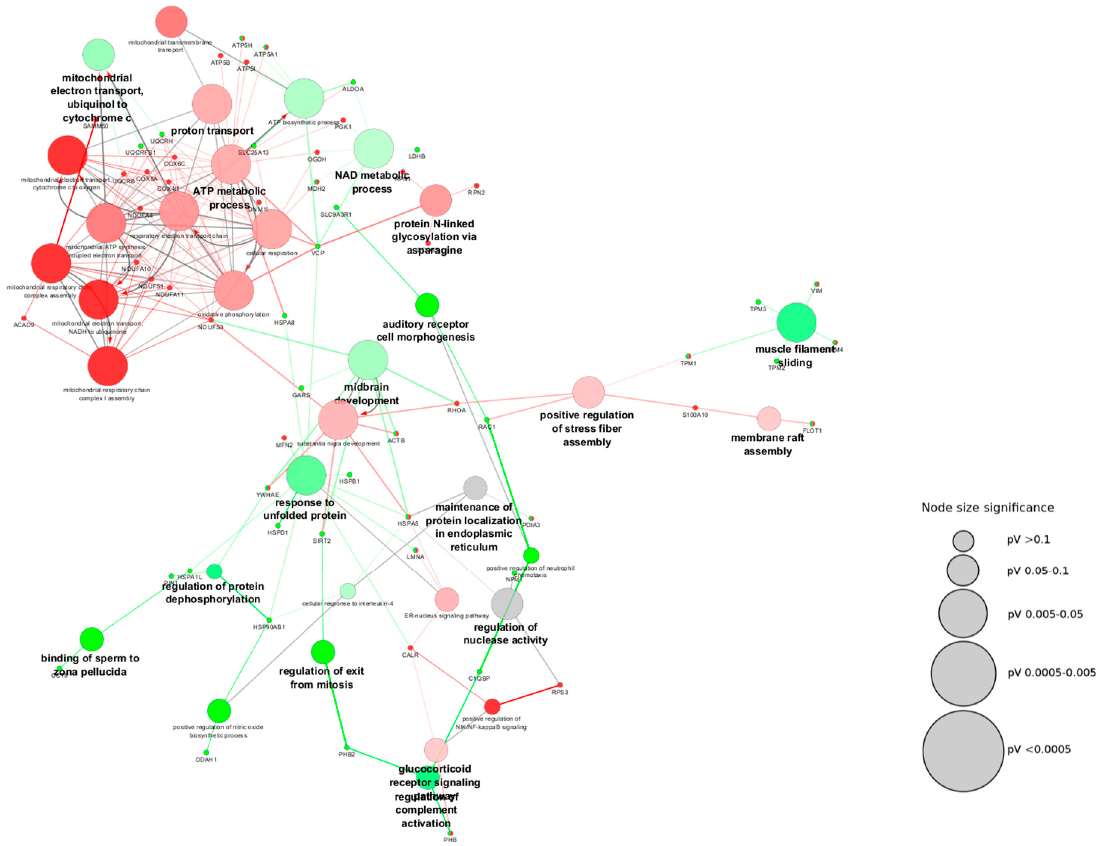
Figure 5. Cytoscape network of the main biological processes associated with mitochondrial-shaping proteins in the context of Parkinson’s disease. The binding partners of the mitochondrial-shaping proteins found modified in different proteomics-based approaches in the context of Parkinson’s disease were subjected to network analysis using the plugin ClueGo from the software Cytoscape to analyze the biological processes affected in the disease. Gray scale nodes correspond to biological pathways that were found to be equally up- and downregulated in different studies, while green and red nodes are representative of upregulated and downregulated biological pathways, respectively, in the context of Parkinson’s disease. The increase in green and red color gradient represents higher amounts of the contribution of up- and downregulated proteins, respectively. The size of the nodes is indicative of their statistical significance. Table 4. List of biological processes related to the mitochondrial-shaping proteins affected in Parkinson’s disease.